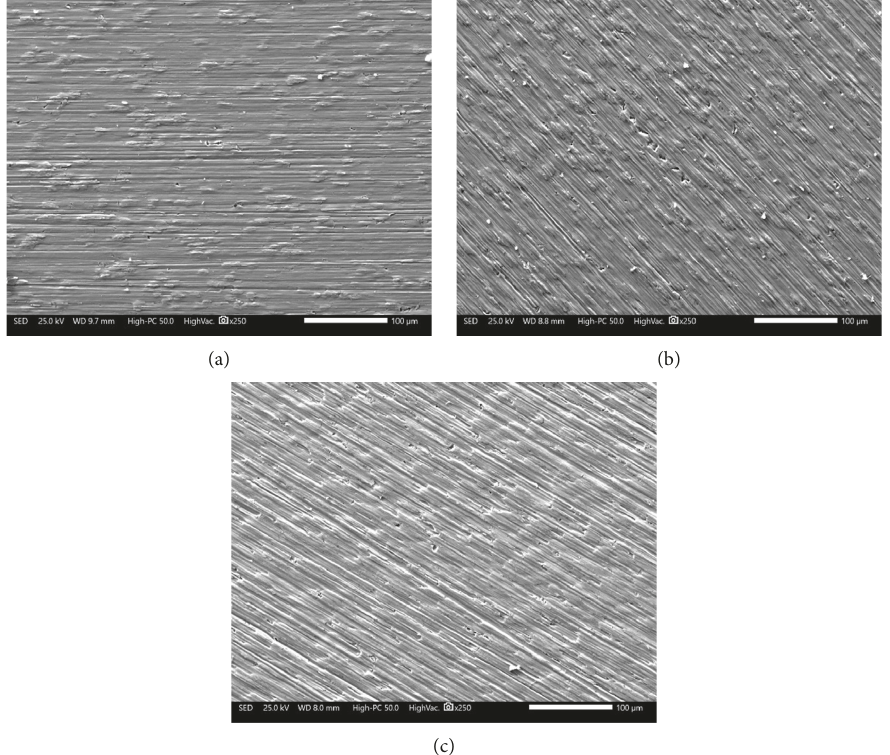
Figure 9: Morphological aspects of Ti biomaterials after the corrosion test in 0.9% NaCl solution at 37 ° C for 100hours: (a) Ti Switzerland; (b) Ti Mexico; (c) Ti CP.